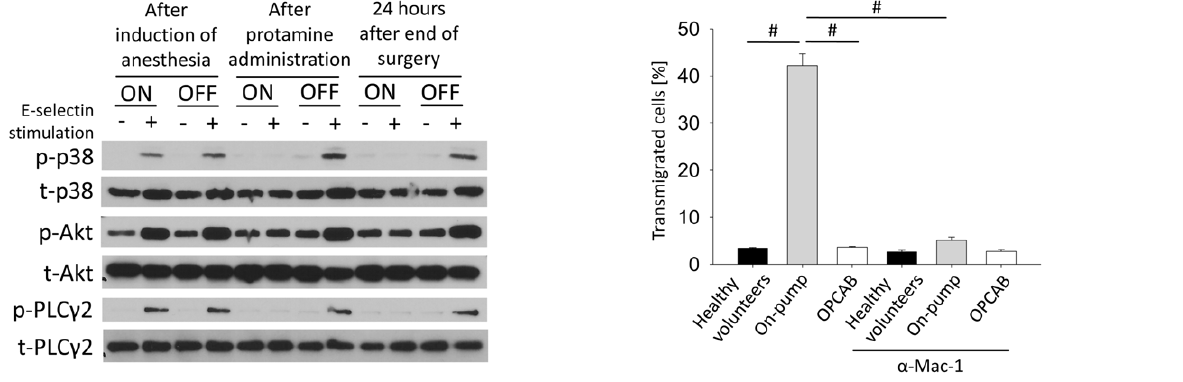
Figure 5. CPB causes increased Mac-1 dependent neutrophil transmigration invitro. Isolated neutrophils from healthy volunteers were preincubated with control serum (black bars) or serum obtained from cardiac surgery patients operated with the use of CPB (grey bars) or in OPCAB technique (white bars) at 37 u C for 30 minutes in the presence or absence of a blocking Mac-1 antibody. The neutrophils were allowed to transmigrate through a confluent HUVEC monolayer in a transwell system in vitro . The endothelial cell layer has been stimulated with TNF- a for 16 hours. After 30 minutes, the number of transmigrated neutrophils was determined (n=3). # p ,